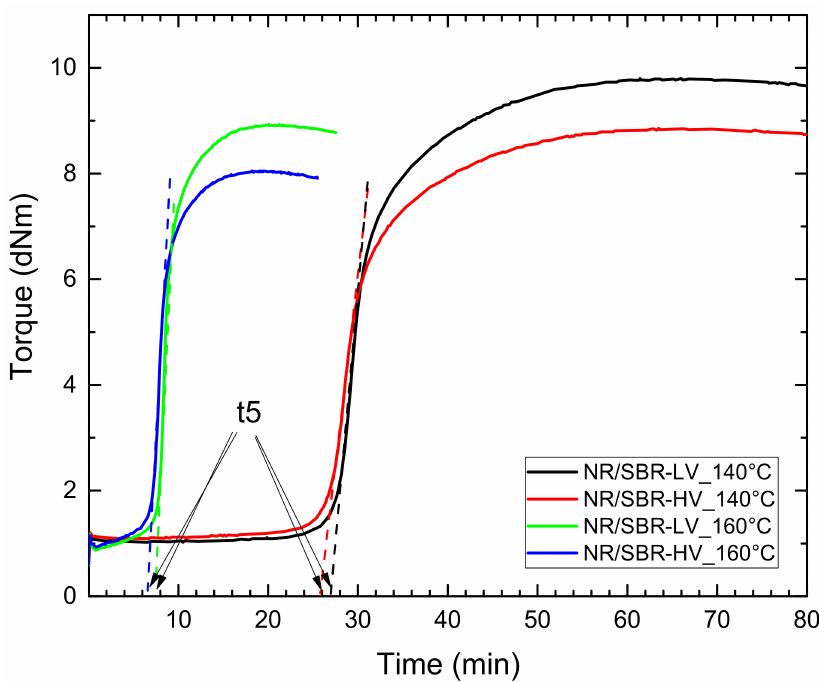
Figure 1. Curing curves (solid lines) of NR/SBR–LV and NR/SBR–HV blends at curing temperatures of 140 and 160 ◦ C. The dashed lines are linear fitting to the curing curves in the region with the steepest slope, and show the approach to define the onset point